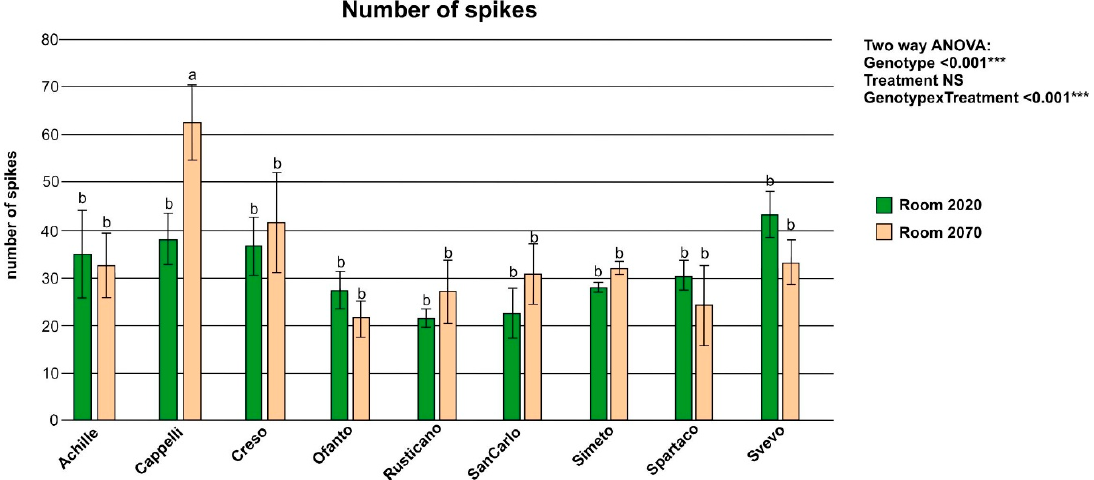
Figure 4. Number of spikes per pot grown in “room 2020” and in “room 2070”. Each biological replicate had three seedlings per pot. Top right: Two-way ANOVA results (NS: not significant; *** p < 0.001). Letters a and b refer to significantly di ff erent means across the genotypes and the treatment (Tukey-HSD post hoc test, p < 0.05).